Question: Write a single sentence explaining what this figure depicts.
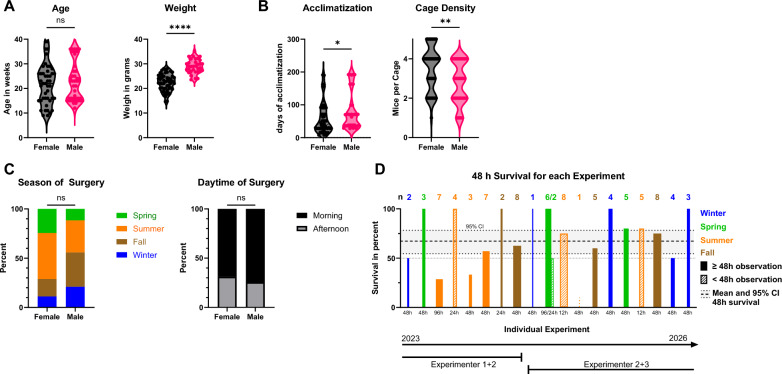
Answer: Baseline parameters. A , Violin plots display the age and baseline body weight of female (black) and male (red) mice. B , Violin plots of acclimatization time in days and cage density in mice per cage of female (black) and male (red) mice. C , Stacked bars plot of the season and daytime of surgery. D , Bars plot of the 48 h survival in each of the 19 individual experiments, with the width corresponding to the number of animals as displayed above the column. Mean survival (bold dotted line) and 95% CI (dotted lines) are shown for experiments lasting at least 48 h. Experiments with a shorter observation period are indicated by hatched bars. The observation time for each experiment is noted below the corresponding bar. The bar for Experiment 10 is divided into two segments, as a subset of animals was followed for up to 24 h, whereas the remaining animals were observed for up to 96 h. Violin plots in A-B with median and Kernel Density. Welch test ( A weight graph), Mann–Whitney test ( A age graph, B ), Chi-square test ( C ). * P < 0.05, ** P < 0.001, **** P < 0.0001